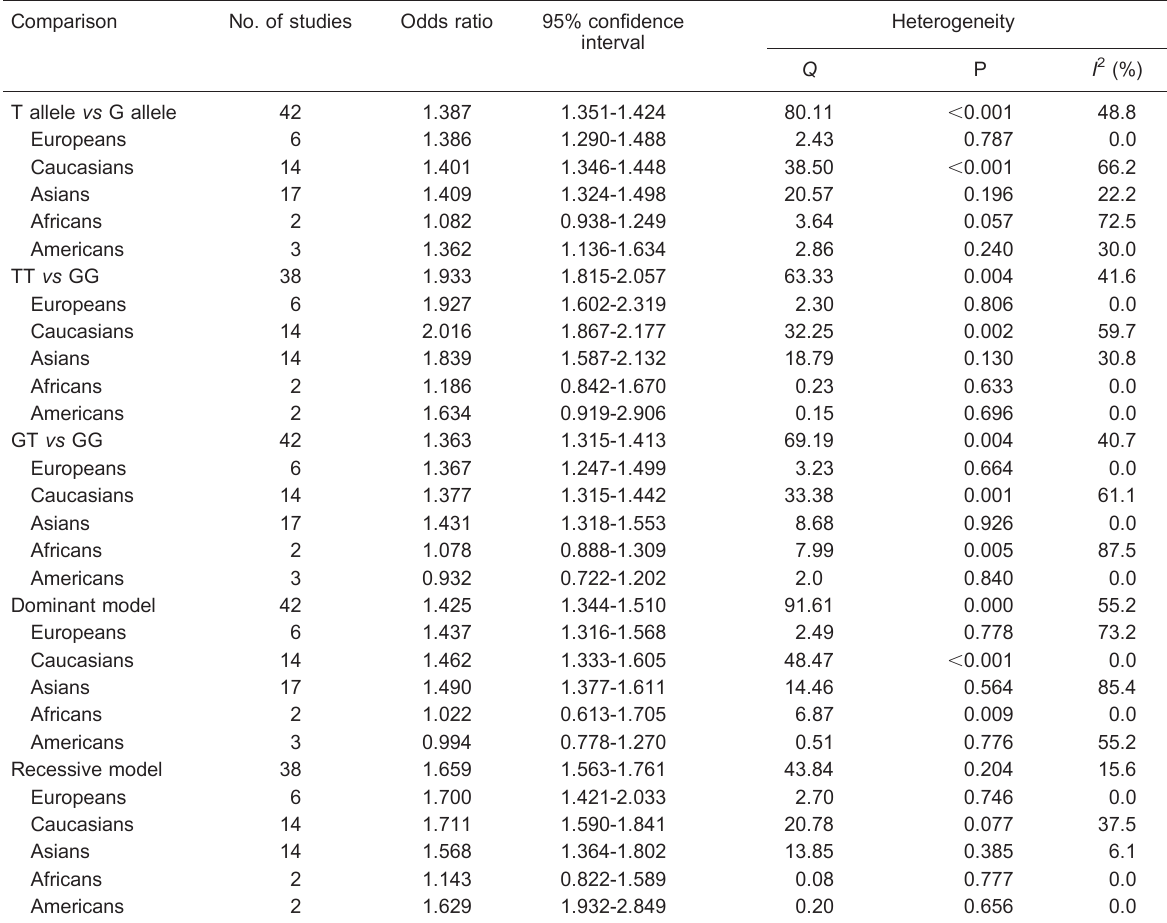
Table 2. Results of meta-analysis for rs12255372 and type 2 diabetes.